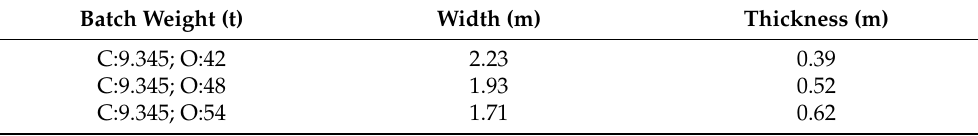
Figure 11. Shape of the ore-free zone with di ff erent ore batch weights. Table 9. Width and thickness of the ore-free zone under different ore batch weights. Batch Weight (t)